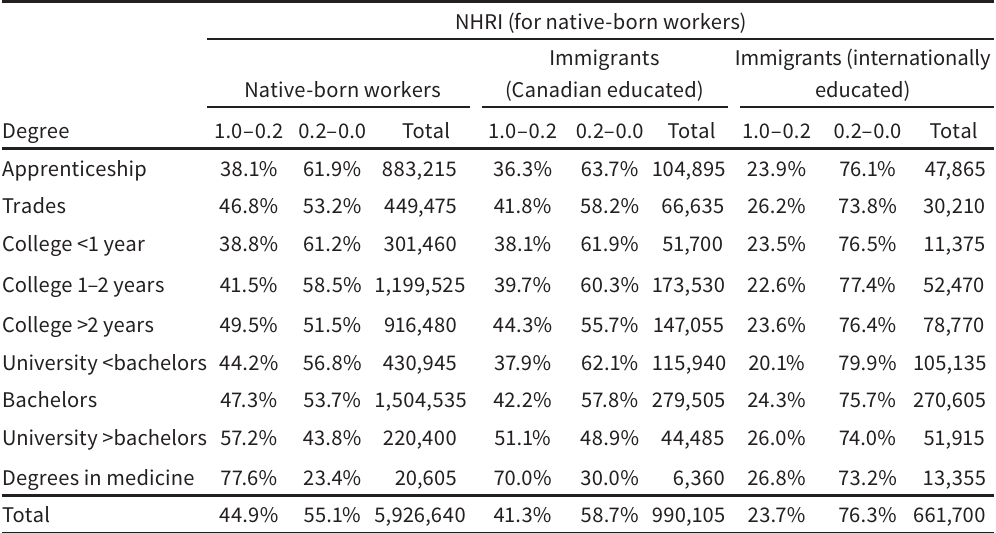
Distribution of native-born and immigrant workers by NHRI and